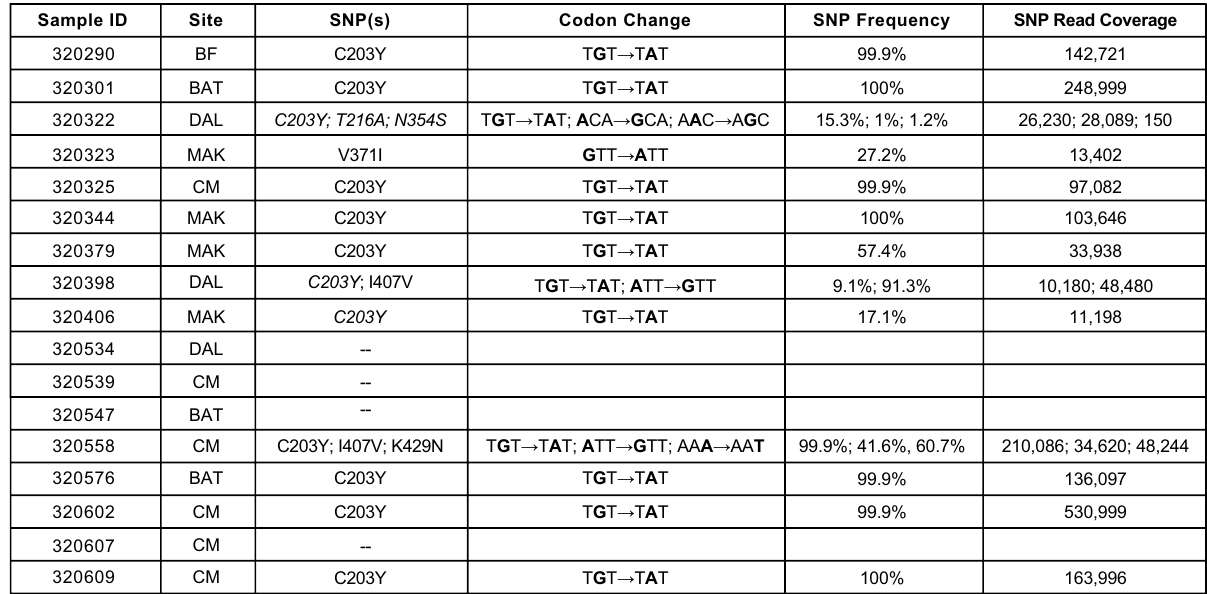
Figure 3. Novel SNPs in PfRh5 discovered through NGS at low frequencies. Next Generation Sequencing (NGS) analysis of samples from successful ex vivo invasion assays using a SNP discovery threshold of 1%. Description of the single nucleotide polymorphisms (SNPs) identified in patient samples from Kédougou. Specific site of collection is abbreviated as follows: Bandafassi (BF), Bantaco (BAT), Camp Militaire (CM), Dalaba (DAL), Mako (MAK). Both nucleotide and corresponding nonsynonymous amino acid changes are indicated. Italicized SNPs are those that were identified only with the discovery threshold (compare to Fig. 2). SNP frequency and read coverage at the SNP site (SNP Read Coverage) are also indicated. At this discovery threshold of 1% three samples (320322, 320379, and 320558) are shown to contain more than one SNP, with two of these samples (320322 and 320558) containing three SNPs. Most of these SNPs have been previously described in both published 9,11,13,19,20 and unpublished data generated by the Pf3k project (www.malar iagen .net/pf3k), representing 3248 samples from 40 separate locations in 20 countries 9 . Additionally, novel SNPs (T216A and N354S) were identified. These SNPs have not been previously reported in published or unpublished